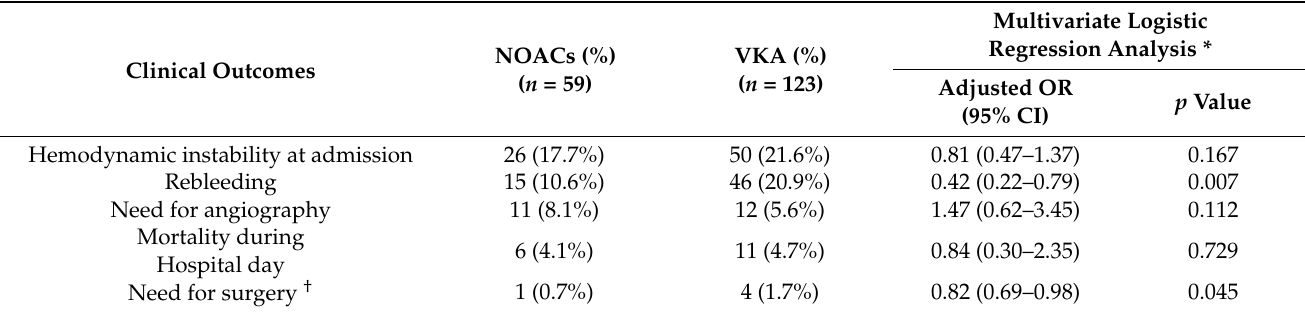
Table 4. Comparison of clinical outcomes in the patients with NOACs vs. VKA.